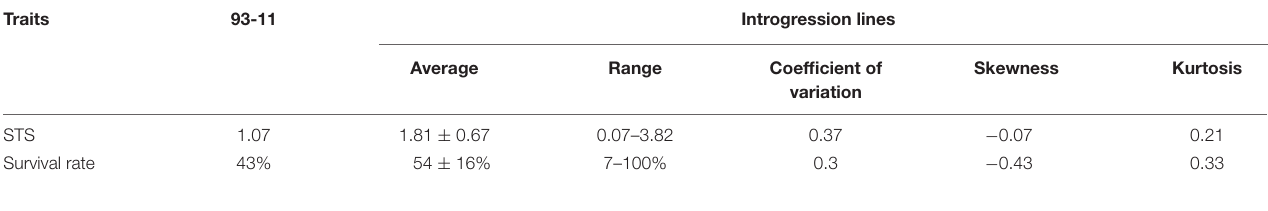
TABLE 1 | Observations of salt tolerance in the recipient parent 93-11 and introgression lines at the seedling stage.